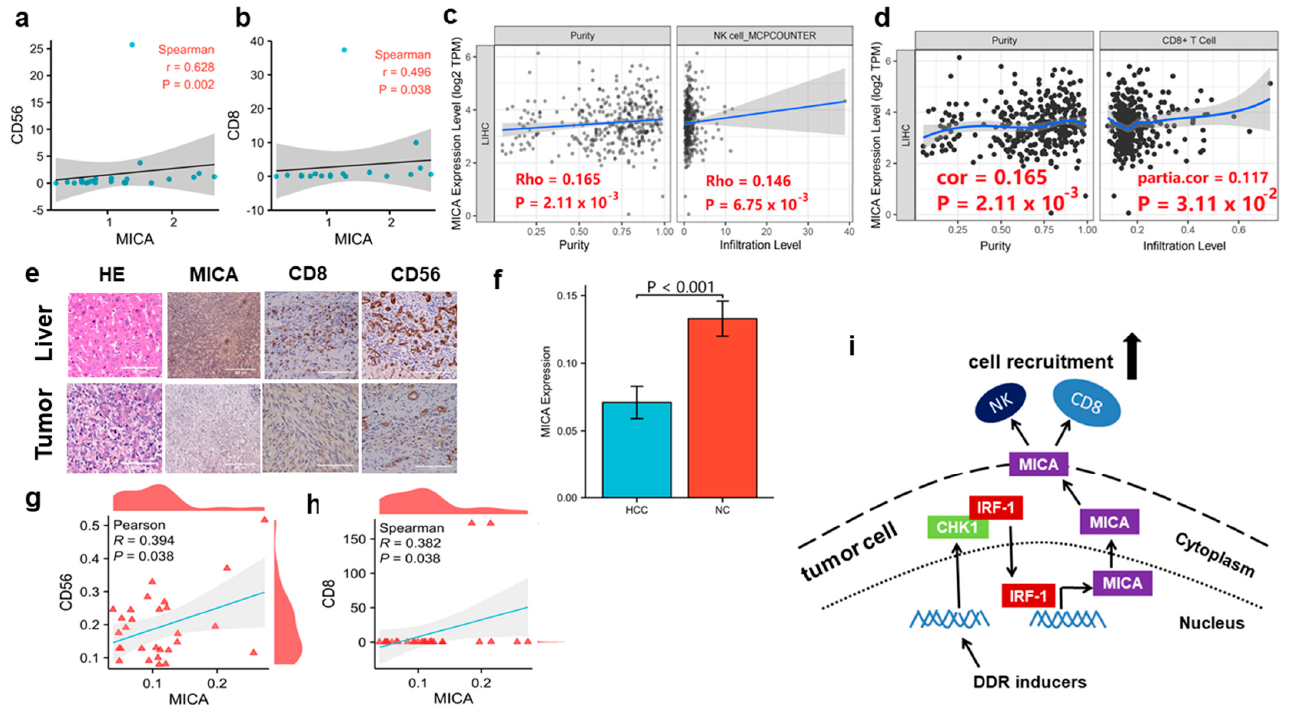
Figure 6. The correlation between MICA and immune cell infiltration in HCC. ( a , b ) The correlation of MICA & CD56 and MICA & CD8 mRNA expression determined by qPCR in pairs of tumor and noncancerous liver tissues from HCC patients were shown ( n = 15). ( c , d ) The correlation of MICA expression and NK cells & CD8+T cells infiltration in HCC tumors from the TIMER database is shown. ( e ) The representative IHC images for MICA, CD8, and CD56 in tumor and noncancerous liver are shown. ( f ) The statistical analysis of MICA protein expression in the tumor compared to the background liver is shown. ( g , h ) Statistical IHC scores for MICA & CD56 and MICA & CD8 are used to determine the relationship in MICA, NK cells, and CD8+T cells ( n = 15). ( i ) A carton depicts that DDR inducers regulate the interaction of CHK1 (green) and IRF1 (red) to promote MICA transcription via IRF1. The increased MICA (purple) activates NK cells (NK) and CD8+T cells (CD8) recruitment in HCC. Each data point represents one patient.